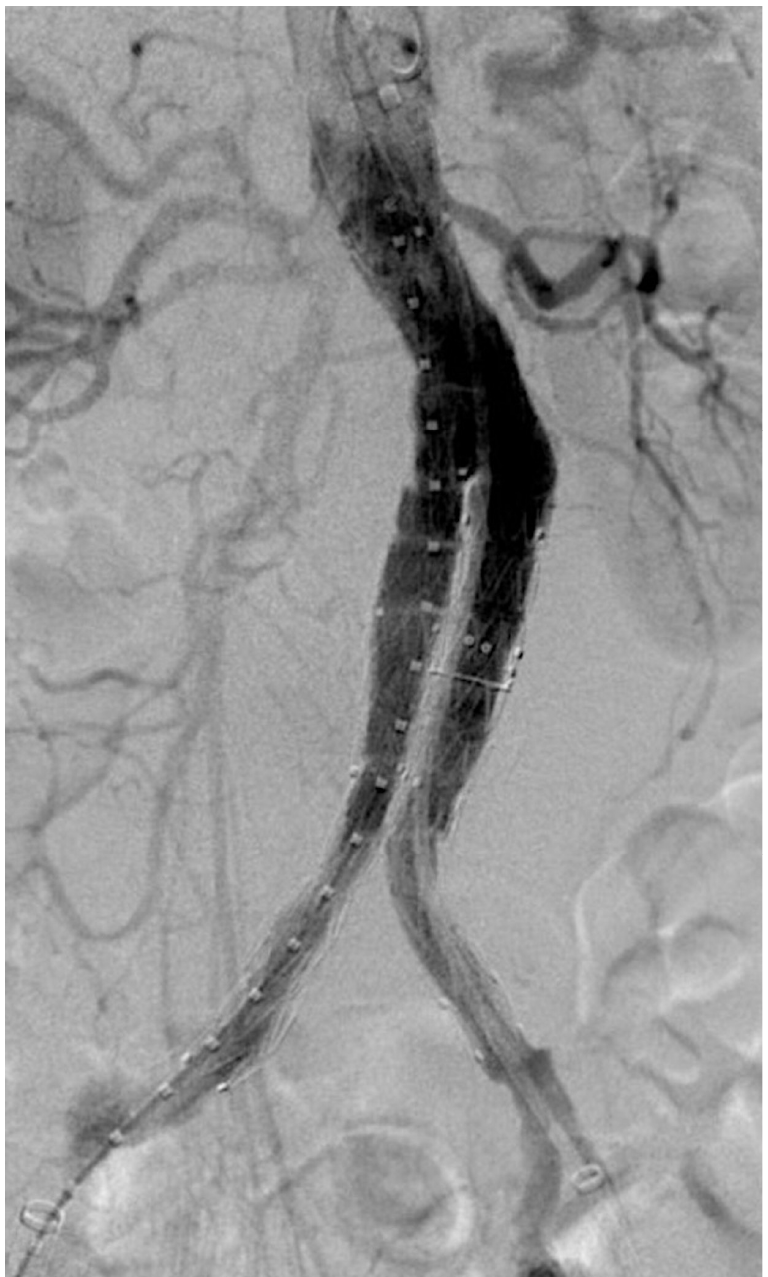
Figure 1. Intraoperative angiography showing complete aneurysm exclusion after Medtronic ® Endurant implantation.